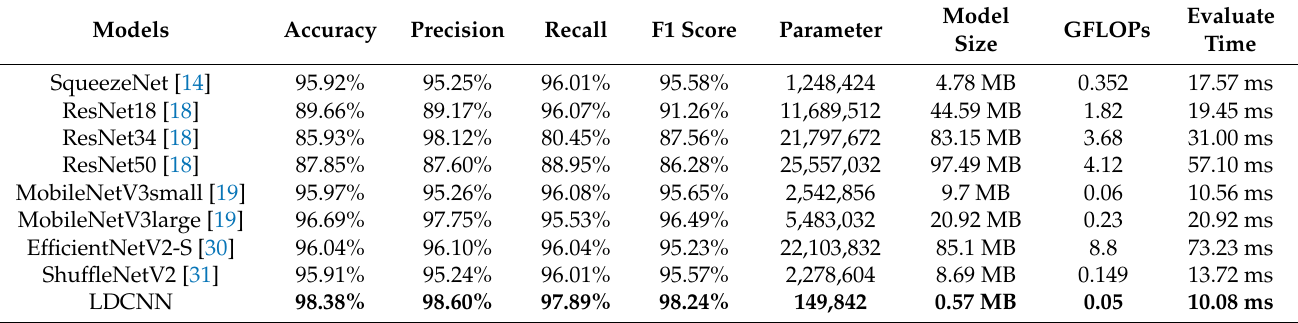
Table 4. Efficiency comparison of each